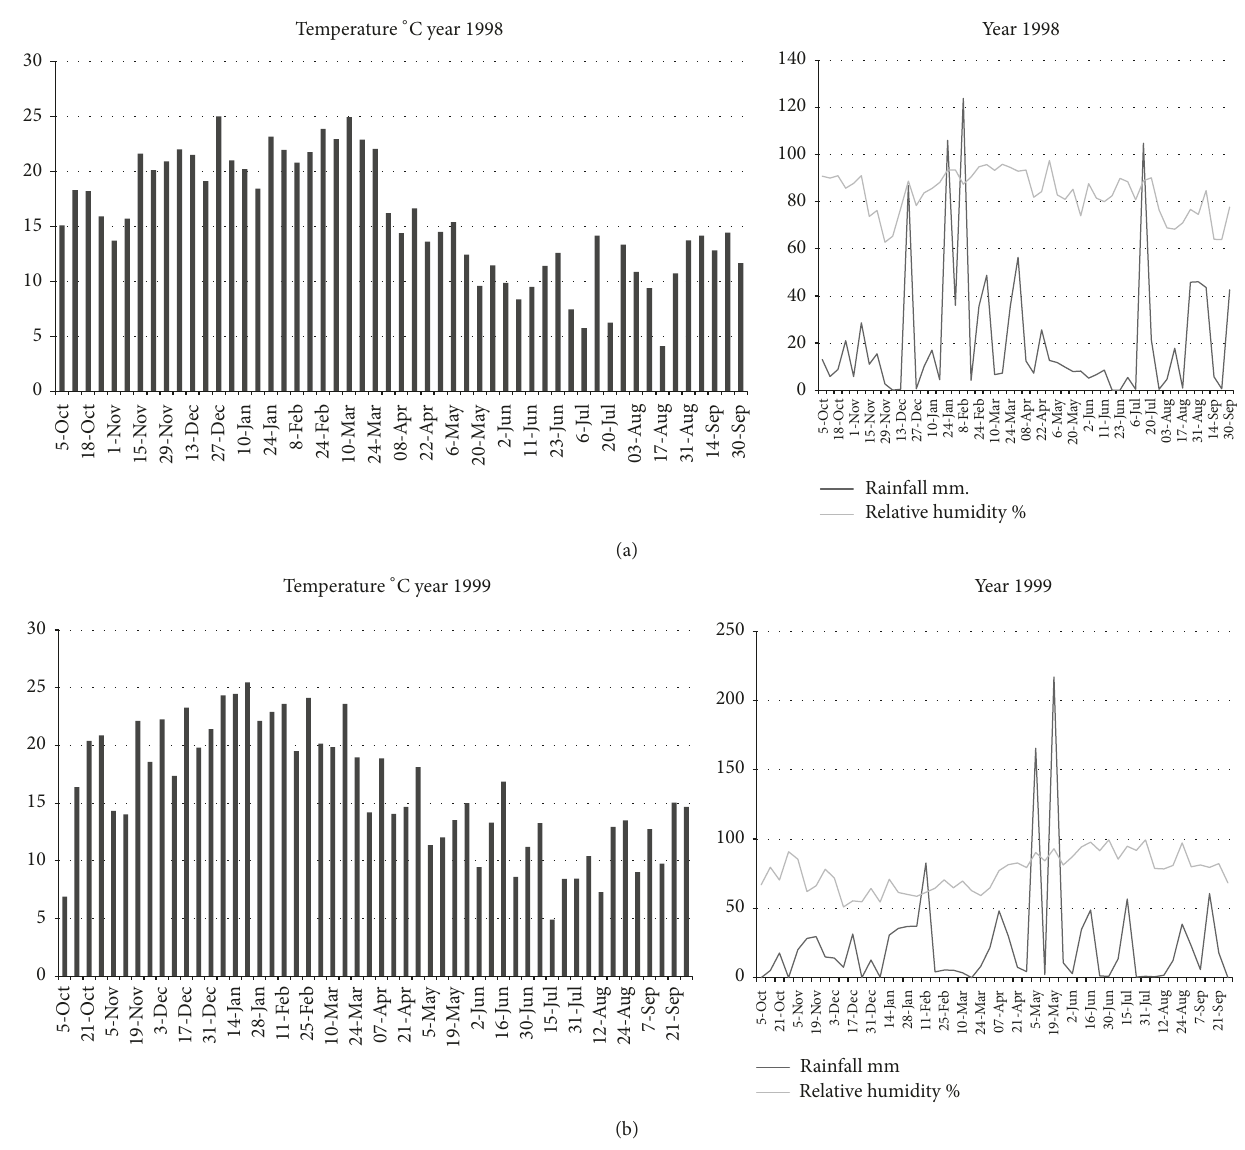
Figure 4: Main parameters of the weather (mean values of rainfall, relative humidity, and temperature at weekly intervals) for (a) 1998- 1999 and (b) 1999-2000 periods. (a) 1998-1999 period = weather variables: rainfall in mm., relative humidity in %, and temperature in ∘ C. (b)1999-2000 period = weather variables: rainfall in mm., relative humidity in %, and temperature in ∘